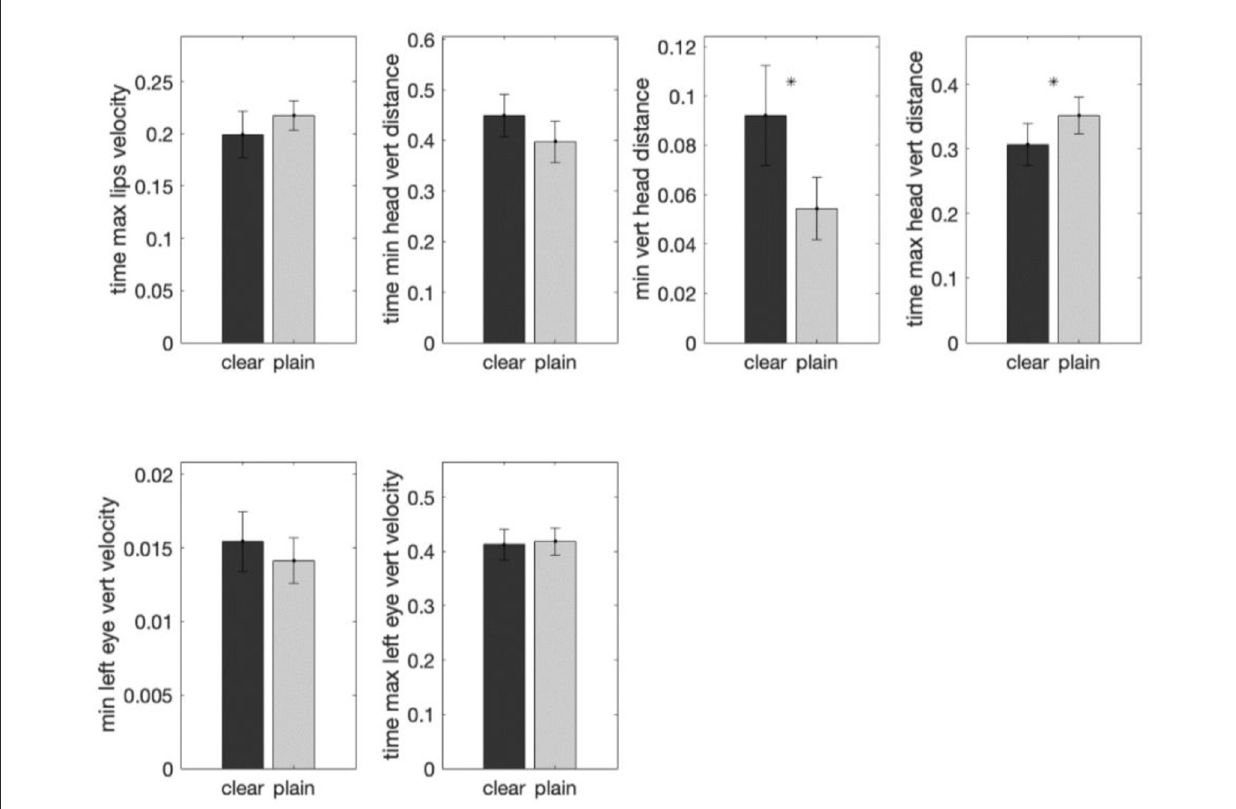
FIGURE5 Comparisons of the group means of each of the six important features (determined by random forest analyses) in clear and plain style in Tone 1. The y-axis shows the average normalized feature value for that particular style group. Two features were found to exhibit a statistically significant difference between the two speech styles by mixed-effects modeling. The error bar on each of the bar plots shows the standard error. A * above a bar represents a p-value smaller than